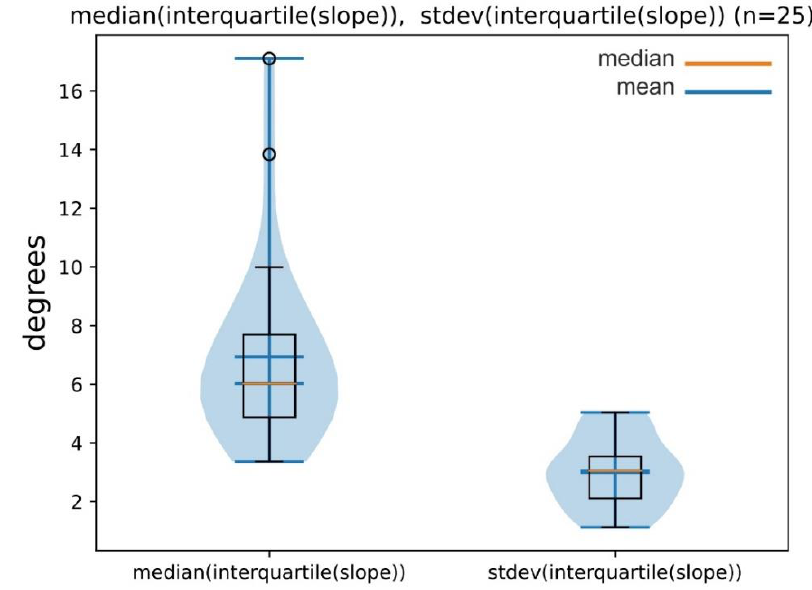
Figure 9. Left: the median values of the interquartile ranges of the sectorial slope distributions for the 25 cones studied of the Chaîne des Puys; right: the standard deviations of the same.